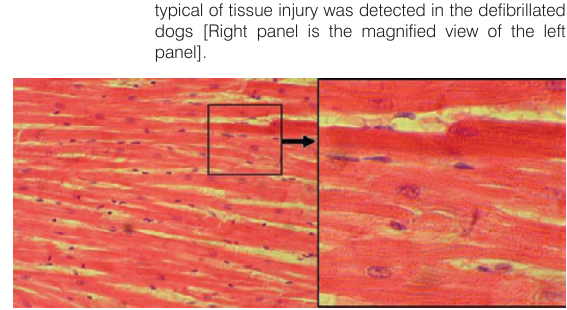
Figure 6. Electron micrographs of heart muscles of defibrillated dogs. Note that the nucleus is intact [white